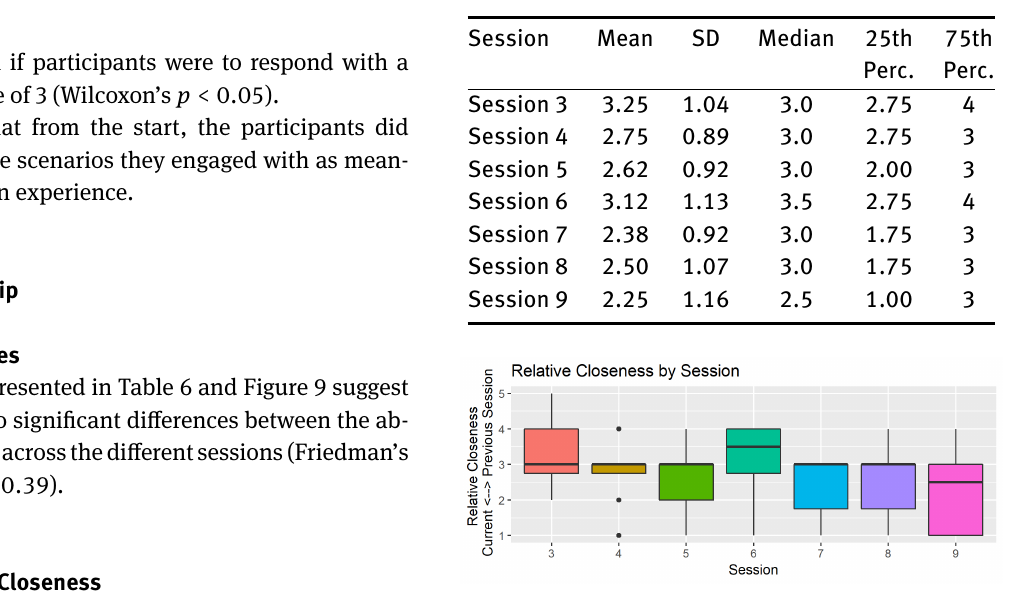
Figure 10: Relationship across sessions measured by Relative Closeness by